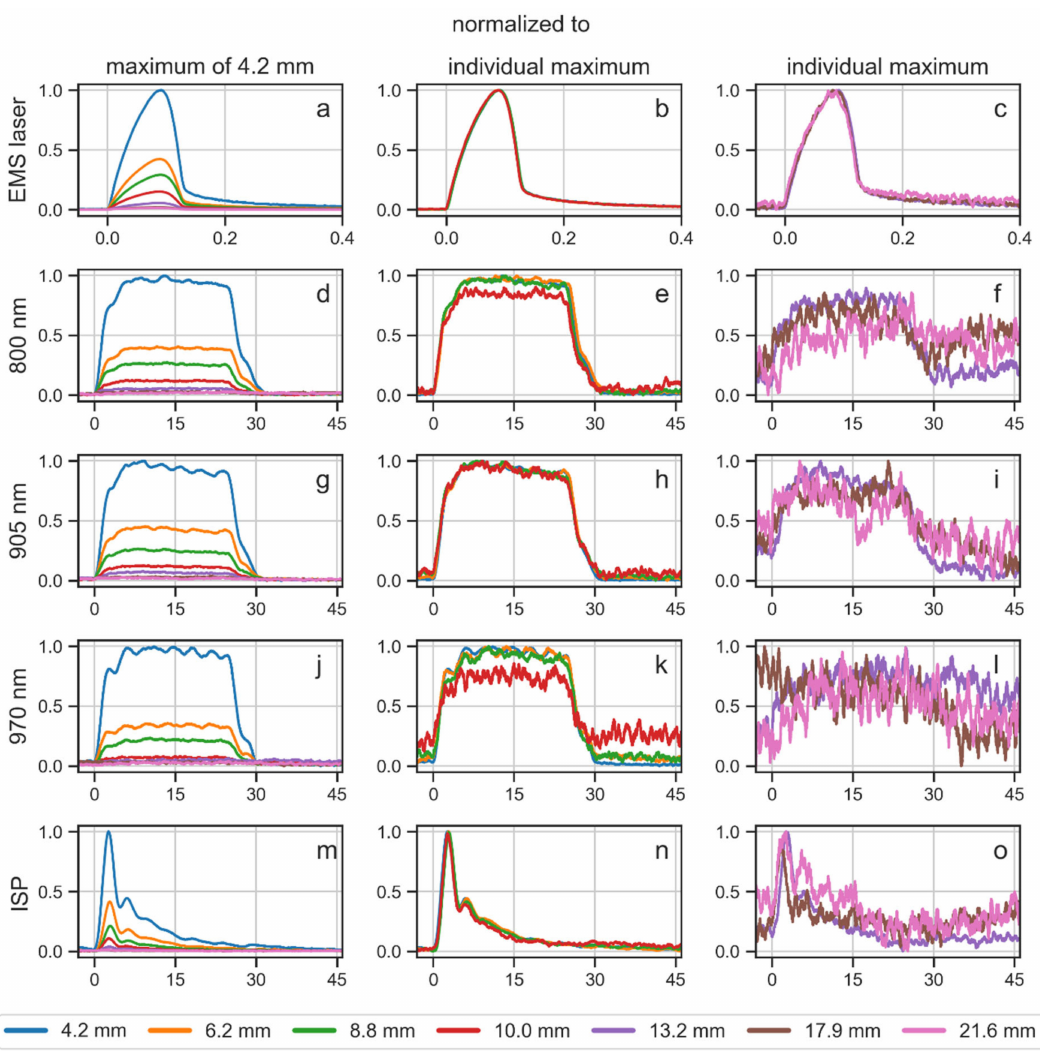
Figure 8. Laser beam pulses in time [ µ s] after transmission through porcine skin specimens of varying thickness: EMS laser ( a – c ) and the different modes of the K-laser ( d – o ). Pulse intensities were normalized to the maximum of the thinnest porcine skin specimen ( a , d , g , j , m ) or to their individual maxima ( b , c , e , f , h , i , k , l , n , o ), respectively. Since noise levels for thick tissue specimens were often large, pulses that were normalized to their individual maxima are shown in separate columns for thin tissue specimens (thickness between 4.2 mm and 10.0 mm) ( b , e , h , k , n ) and for thick tissue specimens (thickness between 13.2 mm and 21.6 mm) ( c , f , i , l , o ). Note that the x-axis of the EMS laser pulses spans 0.4 µ s each ( a – c ), whereas the x-axis of the K-laser pulses spans 45 µ s each ( d – o ). Accordingly, the laser pulses of the K-laser lasted on average more than 100 times longer than the laser pulses of the EMS